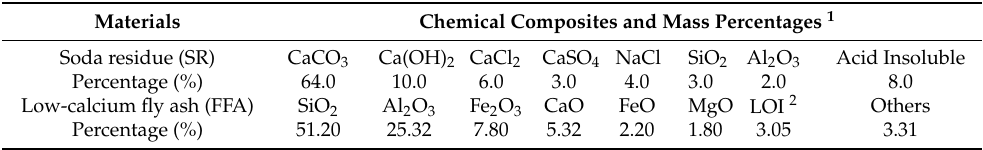
Table 1. Chemical compositions of solid powders by XRF.